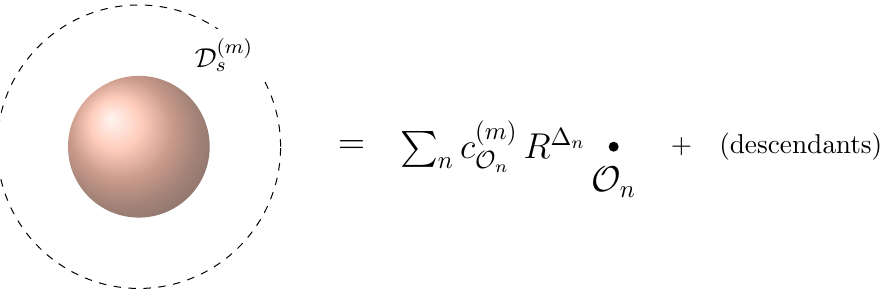
Figure 3 . A spherical conformal defect of radius R has the OPE in terms of bulk local operators located at the